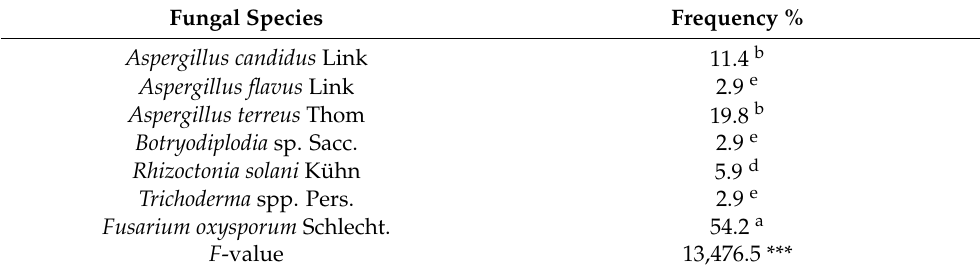
Table 1. Frequency % of fungi associated with RPW during an infestation of date palm roots.